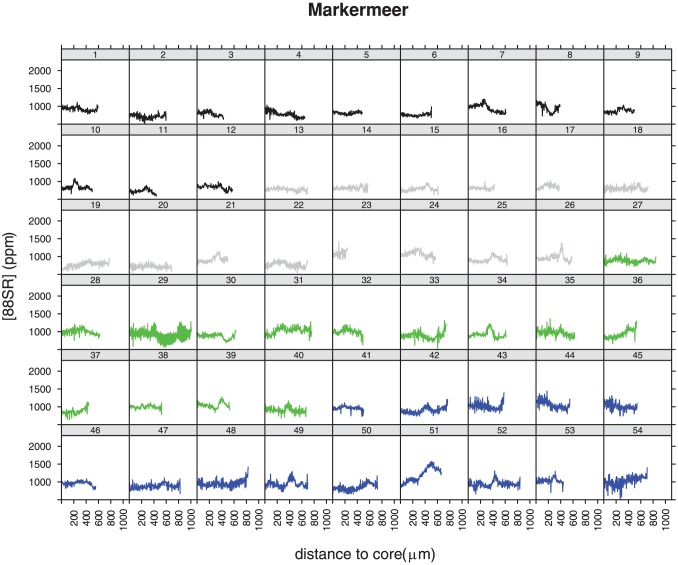
Strontium concentration profiles (in ppm) for smelt caught in Lake Markermeer, going from the nucleus (left) to the outer edge (right).The colours indicate the different hauls, all profiles in one colour originate from the same haul.